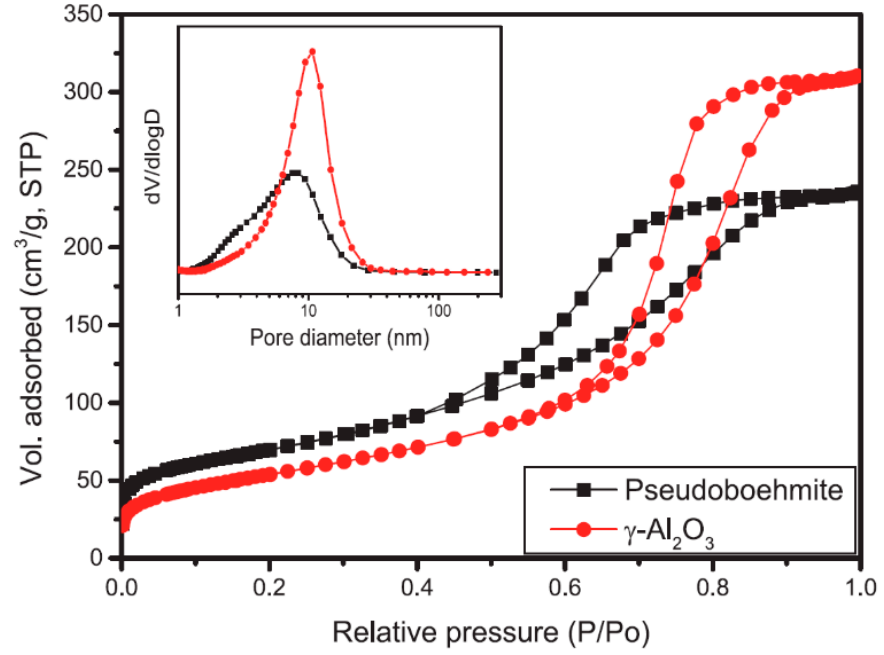
Figure 2. N 2 adsorption and desorption isotherms and BJH pore size distribution for pseudoboehmite and γ -Al 2 O 3 .